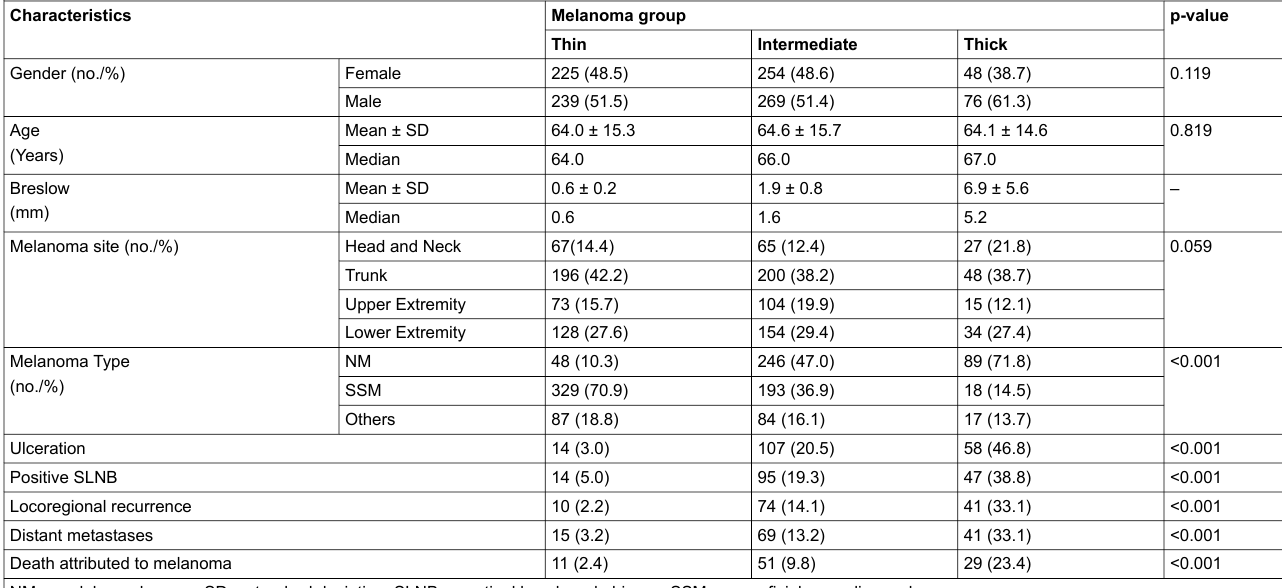
Table 1: Patients and tumour characteristics according to melanoma thickness.